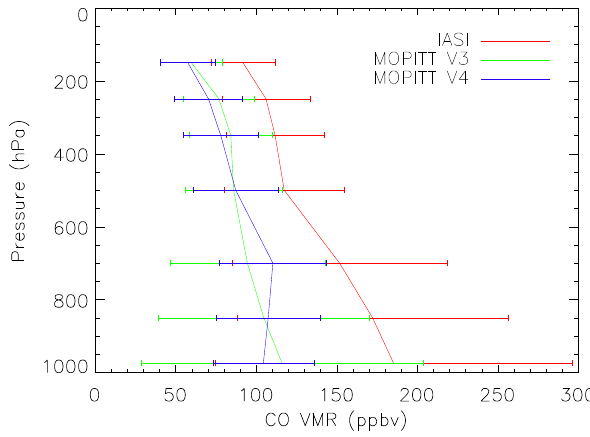
Fig. 1. IASI and MOPITT V3 a priori profile and associated errors (i.e. the diagonal of the a priori covariance matrix), as well as the MOPITT V4 a priori profile averaged over the region shown in Fig. 4 for 1 September 2007. The profiles have all been interpolated onto the MOPITT V3 pressure grid for ease of reference